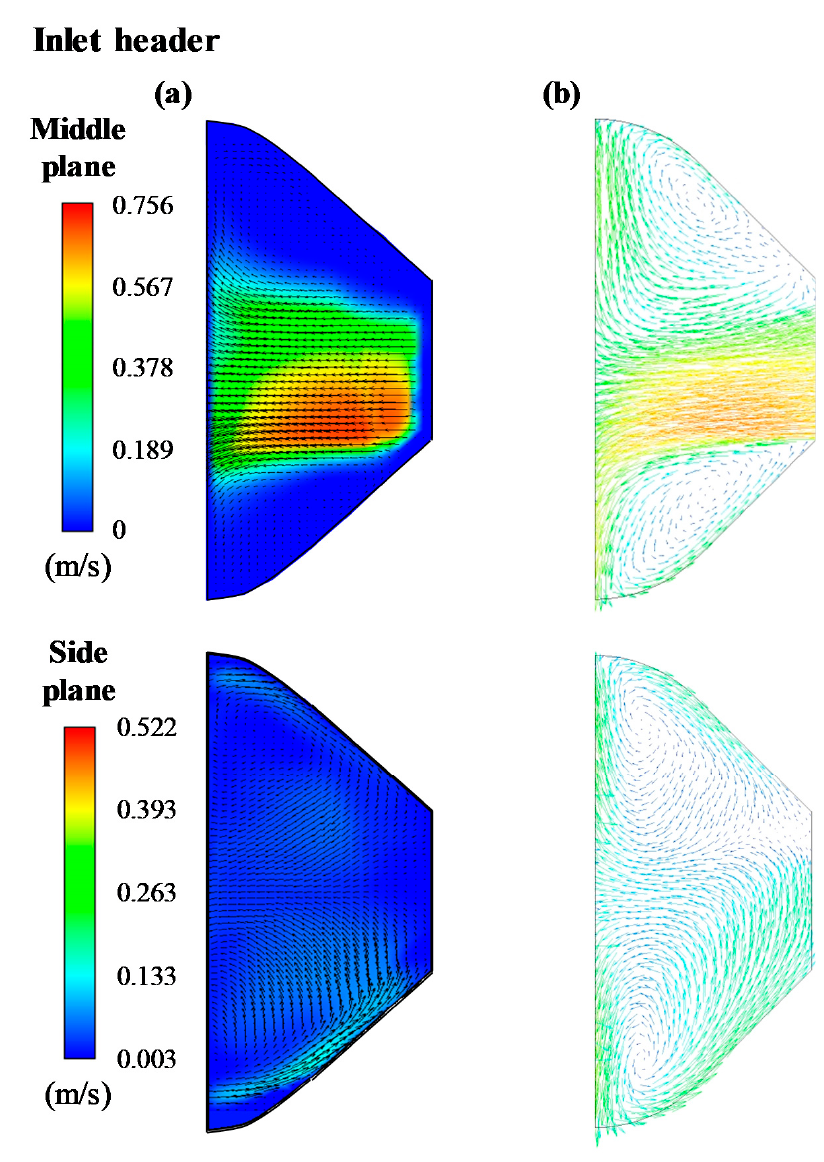
Figure 13. Velocity fields and contours in the inlet header when the perforated plate is not installed: ( a ) experiment and ( b ) numerical simulation.